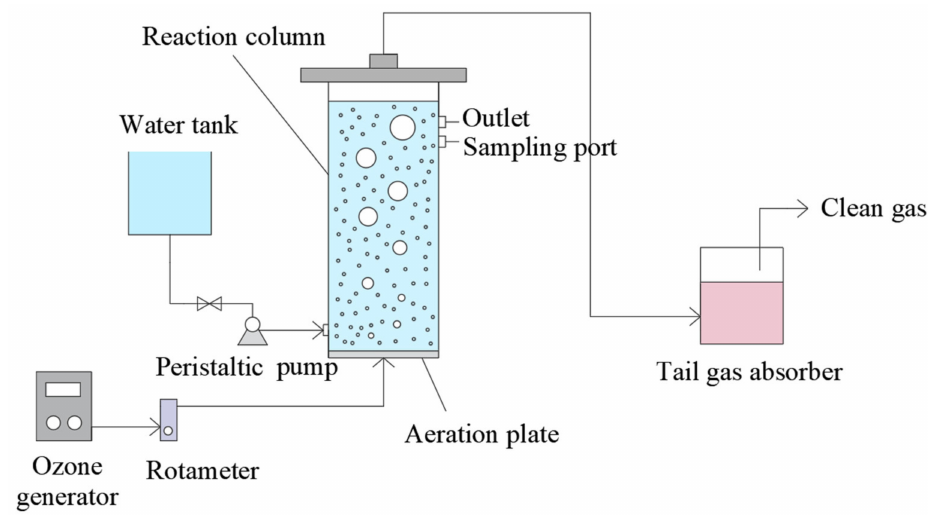
Figure 1. Schematic of the ozonation treatment